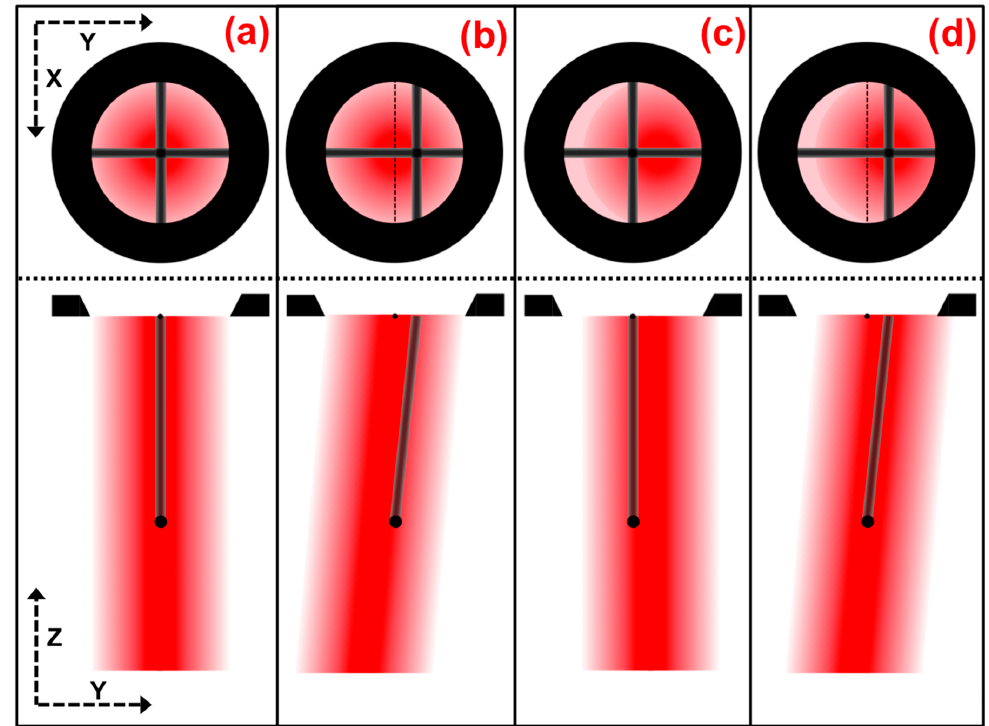
Figure 5. Illustrations of beam alignment: Bottom illustrations are side cross sections of the beam path, showing the beam position and trajectory, and shadow path of the cross bar up to the cross-hair screen opening. Top illustrations are depictions from a view down on the cross-hair screen, showing cross-bar shadow and beam-center alignment for the respective states. ( a ) Illustration of illumination beam alignment parallel and coincident with the optical axis. ( b – d ) Illustration of illumination beam in several possible, and commonly occurring, states of misalignment.